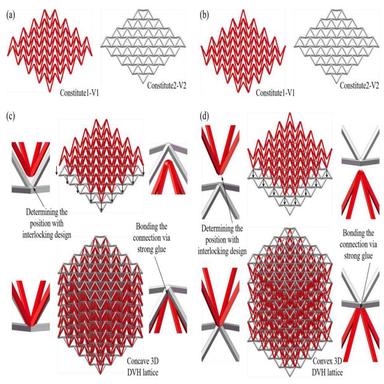
Schematic diagram of the fabrication process of the composite 3D DVH lattices by the assembly method, (a) and (b) print two pyramid lattice structures with different inclined angles and constitute materials, stack pyramid lattice structures, determine the positions with interlocking design and bond connections via strong glue to form monolithic (c) concave and (d) convex 3D DVH lattices.